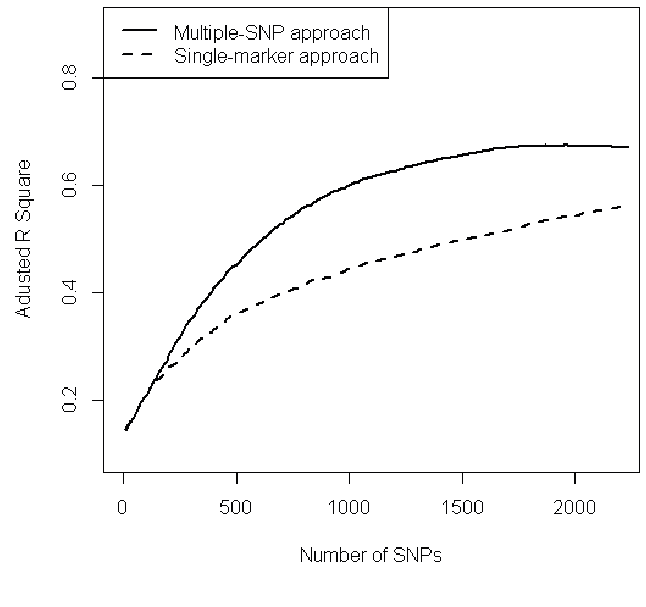
Figure 3. Phenotype variation between multi-stage approach (solid line) and single-marker approach (dashed